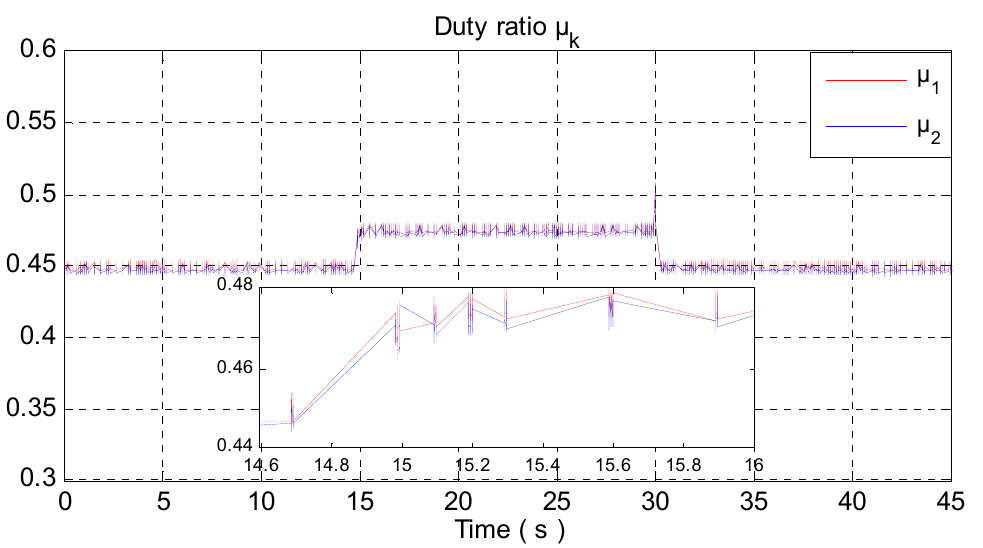
Figure 23. Control signals μ k with zoom.